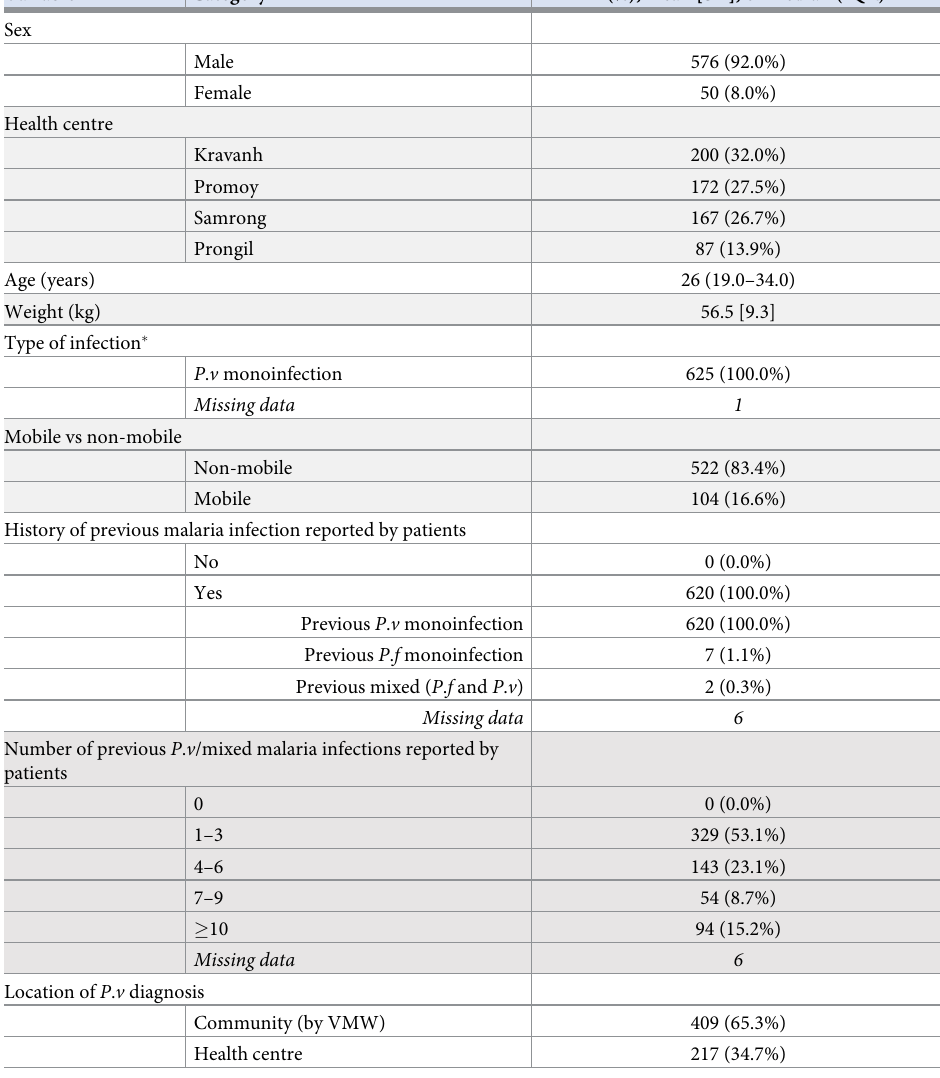
Table 3. Characteristics of the study population (N =